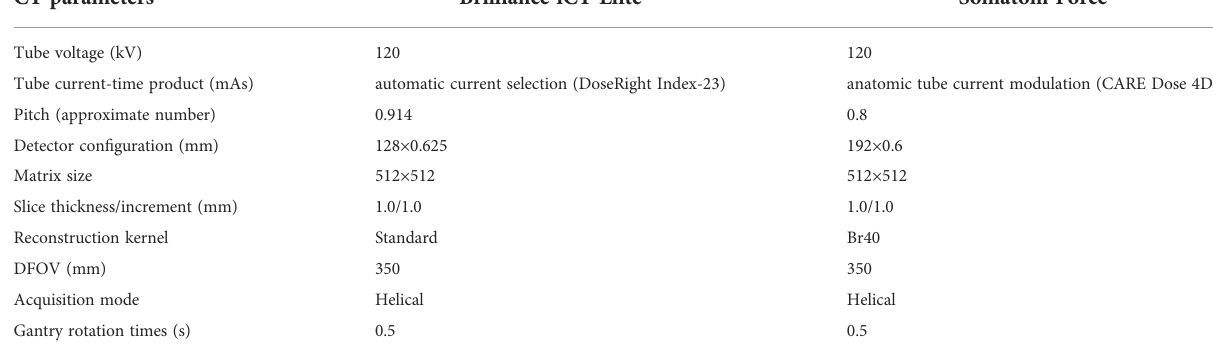
TABLE 1 Summary of acquisition parameters of 2 CT